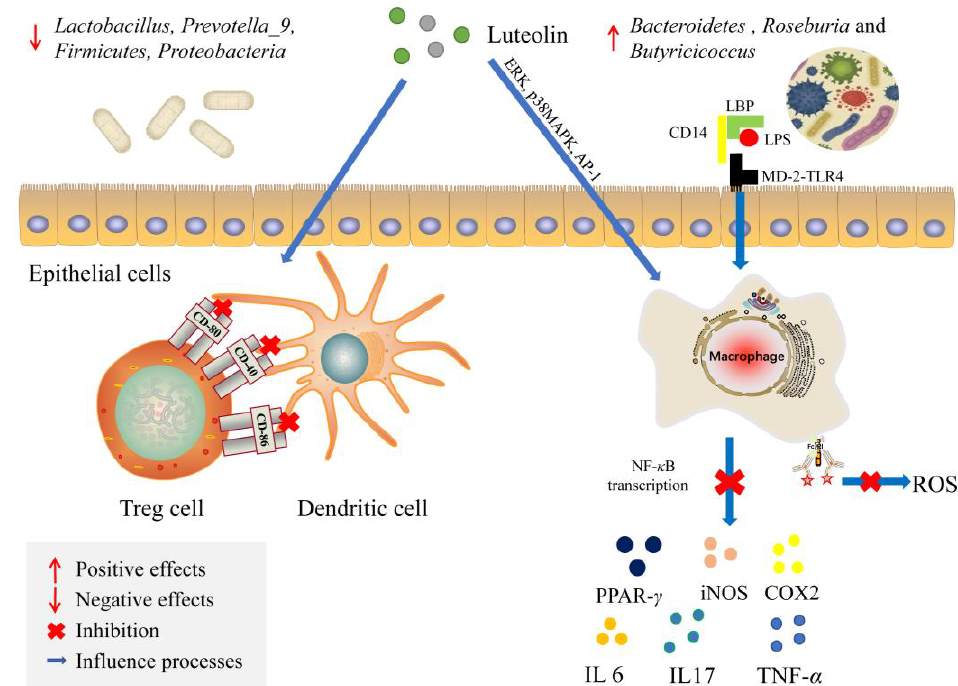
Figure 2. Regulation mechanisms of luteolin in the inflammation. ROS: Reactive oxygen species; LPS: Lipopolysaccharide; LBP: Lipopolysaccharide binding protein; CD: Clusters of differentiation; TLR4: Toll-like receptor 4; NF- κB: Nuclear factor kappa B; IL: Interleukin; iNOS: Inducible nitric oxide synthase; ERK: Extracellular regulated protein kinases; MAPK: Mitogen activated protein kinase; AP-1: Amphipathic protein-1; COX2: Cyclooxygenase2; TNF- α: Tumor necrosis factor - α.